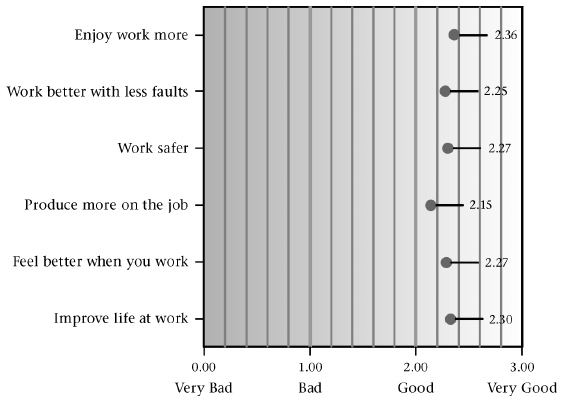
Figure 3:Means of the items pertaining to the resulting